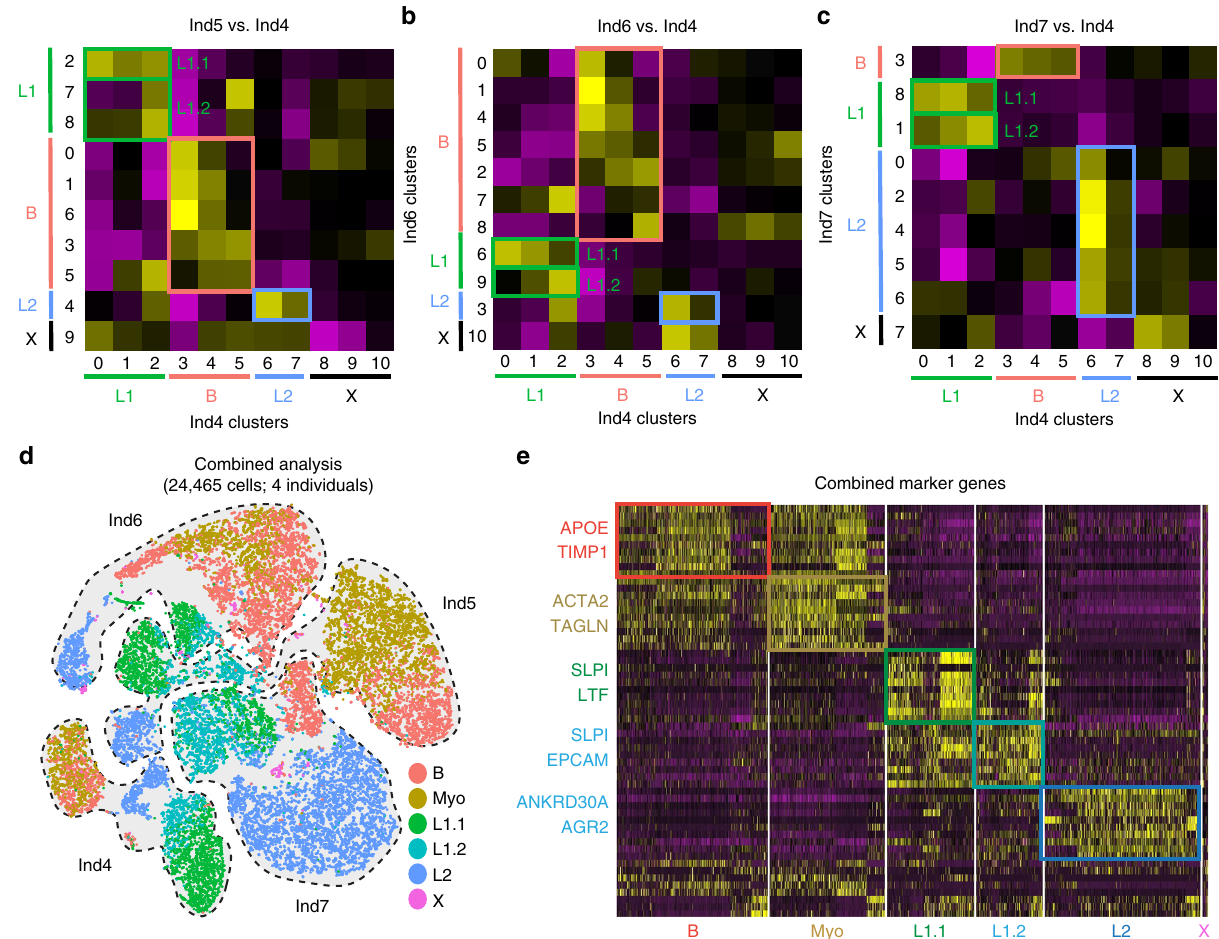
Fig. 3 Combined droplet based RNAseq data to identify generalizable cell types and states. a – c Heatmaps showing gene scoring results using marker genes for Ind4 clusters (0 – 10; on bottom of heatmap) in all clusters from Ind5 ( a ), Ind6 ( b ), and Ind7 ( c ). Individual-speci fi c cluster IDs are shown in different colors on the right and bottom, and cell type IDs for Basal ( b ), L1, L2, X are indicated on for every cluster. Data shown as Z scores from purple (low) to yellow (high). Two distinct cell states L1.1 and L1.2 were found within L1 in all pairwise comparisons as highlighted by colored boxes on heatmap. d Combined tSNE projection of all individual datasets (outlined) is shown including the cell state identity marked by different colors. e Heatmap showing the expression pattern of the top ten markers per cell state with selected markers indicated (yellow = high expression; purple = low expression). See Supplementary Fig. 4 for separate basal cell Seurat analysis, summary of cell state designations and Ingenuity Pathway